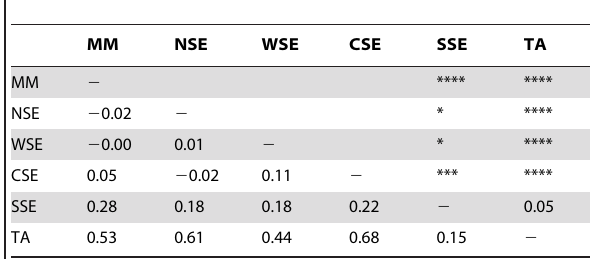
Table 5. F ST value comparison for sampled regions in Serengeti National Park, Tanzania based on mtDNA; F ST values are below the diagonal and significance levels are above; sample names correspond to the northern (NSE), western (WSE), central (CSE) and southern (SSE) regions of Serengeti in addition to Maasai Mara (MM) in Kenya and Tarangire (TA) in